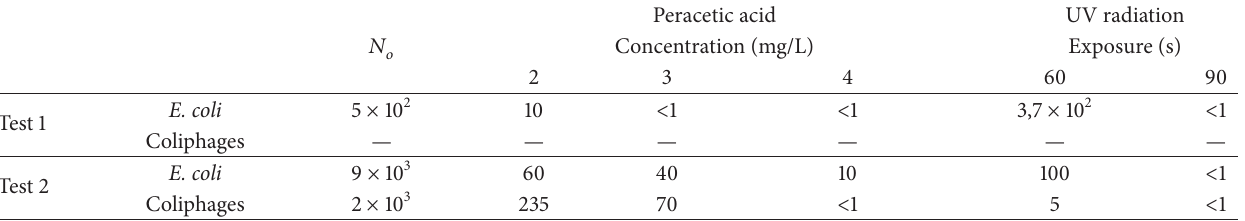
Table 4: E. coli and coliphages inactivation employing PAA and UV radiation individually in tests with water.